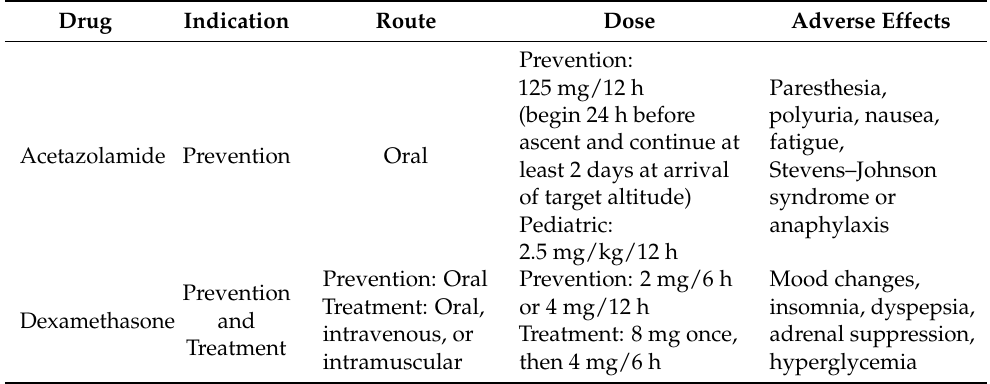
Table 1. Drugs Used in Prevention and Treatment of HACE (recommendations based on Wilderness Medical Society Clinical Practice Guidelines)